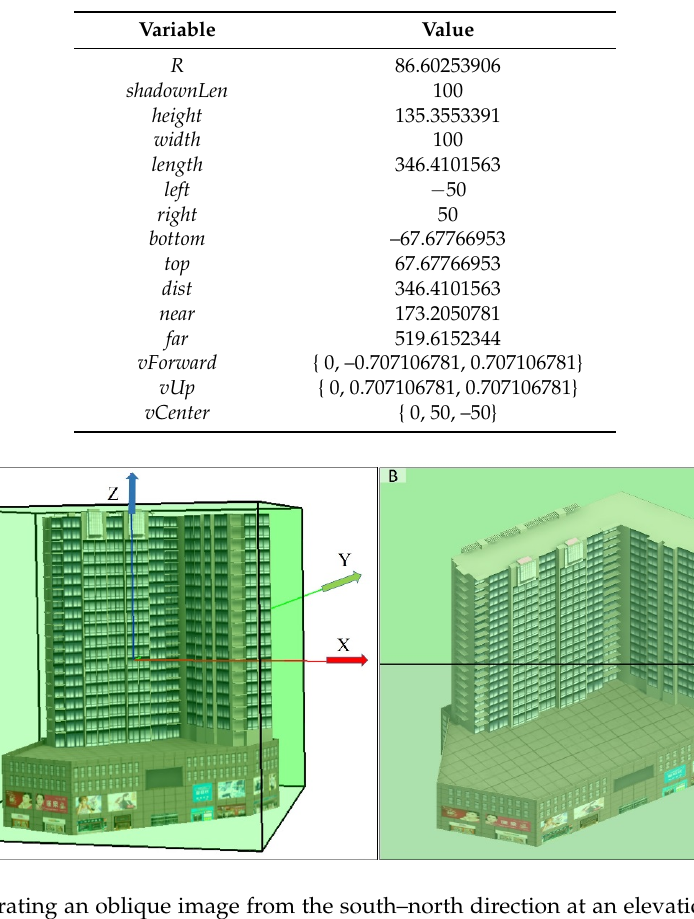
Table 3. Parameterization of the view and projection matrix of an oblique image renderer.